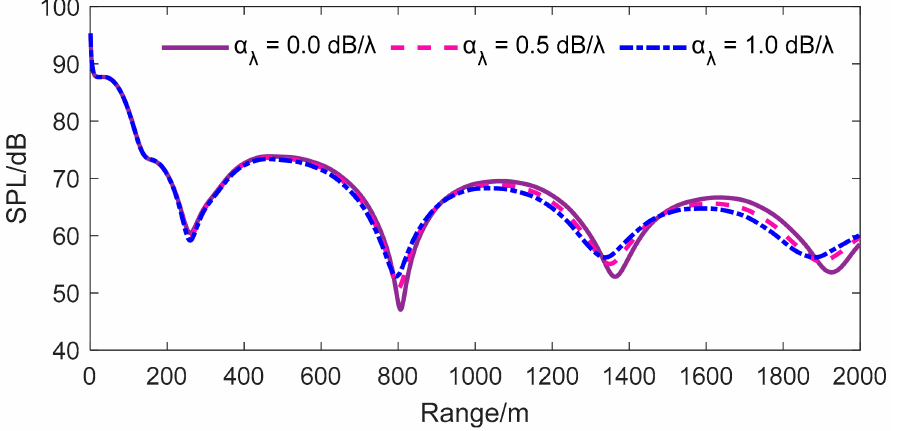
Figure 7. Comparison of sound field propagation with different sound absorption